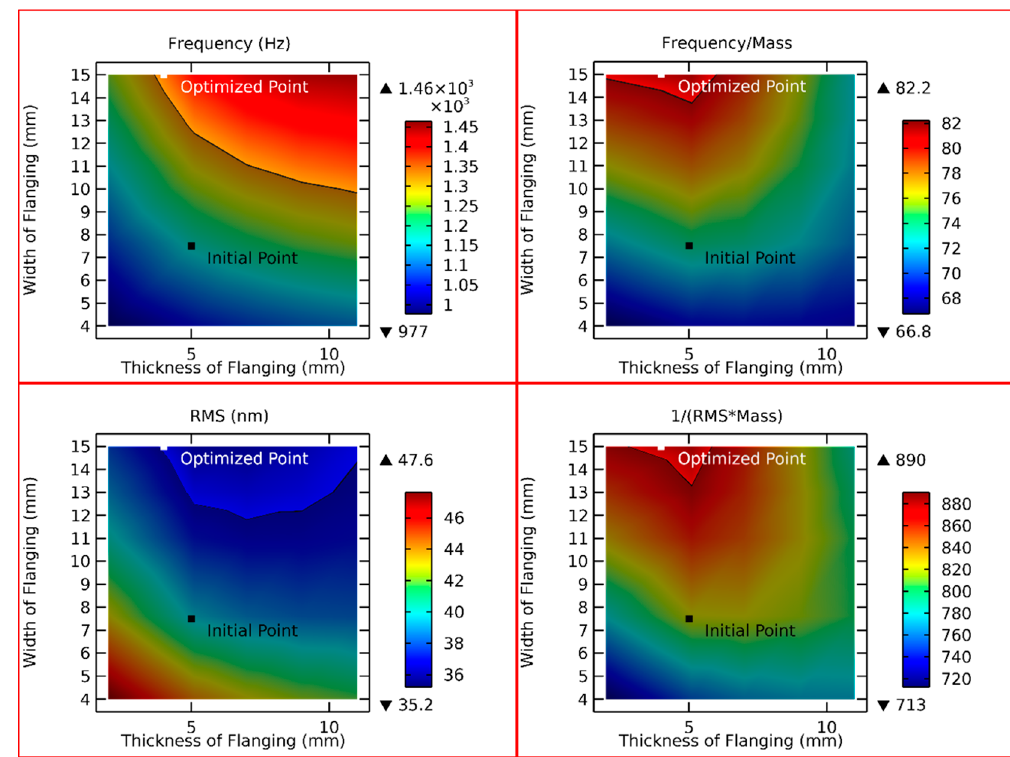
Figure 8. Schematic diagram of an optimization.